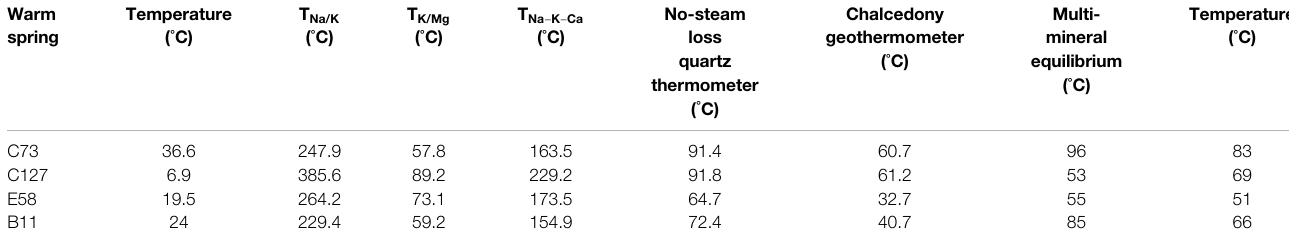
TABLE 4 | Temperature of warm springs in the Jiangcang Basin calculated using geothermometers.